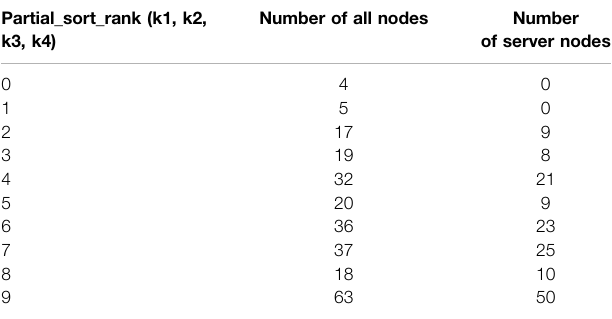
TABLE 3 | The partial order results of the four indicators (k1, k2, k3, k4) in N1. Partial_sort_rank (k1, k2, k3, k4)